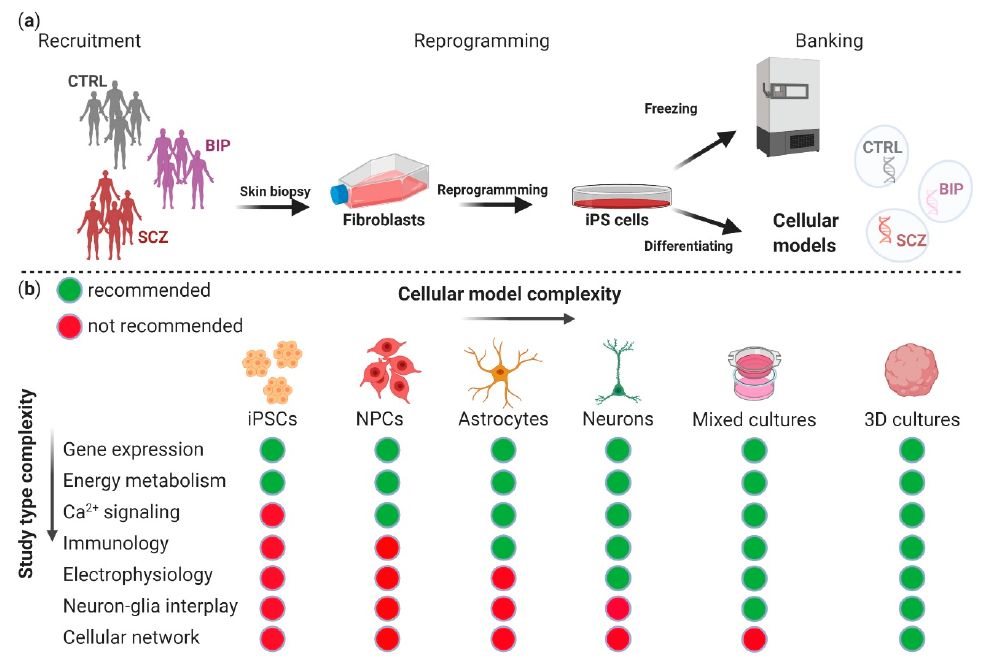
Figure 1. The potential of iPSCmodels to study schizophrenia (SCZ) and bipolar disorder (BIP). ( a ) Scheme showing the process of recruitment, reprogramming of skin fibroblasts into iPSCs, cell banking, and generation of cellular models for healthy controls and patients with SCZ and BIP. ( b ) IPSC-based models listed by complexity and their suitability for different types of studies relevant for SCZ and BIP. CTRL, healthy controls; NPCs, neural progenitor cells.